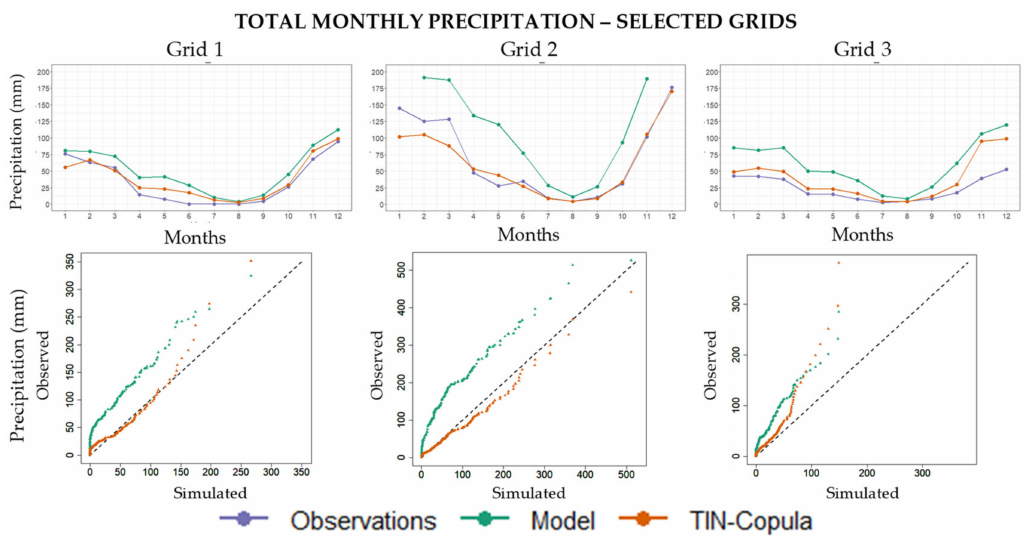
Figure 7. Line plots of the monthly and quantile–quantile plots of the annual total precipitation values of the three selected grid points, presented in Figure 1. ( Grid 1 : coastal grid, Grid 2 : mountainous grid, Grid 3 : continental